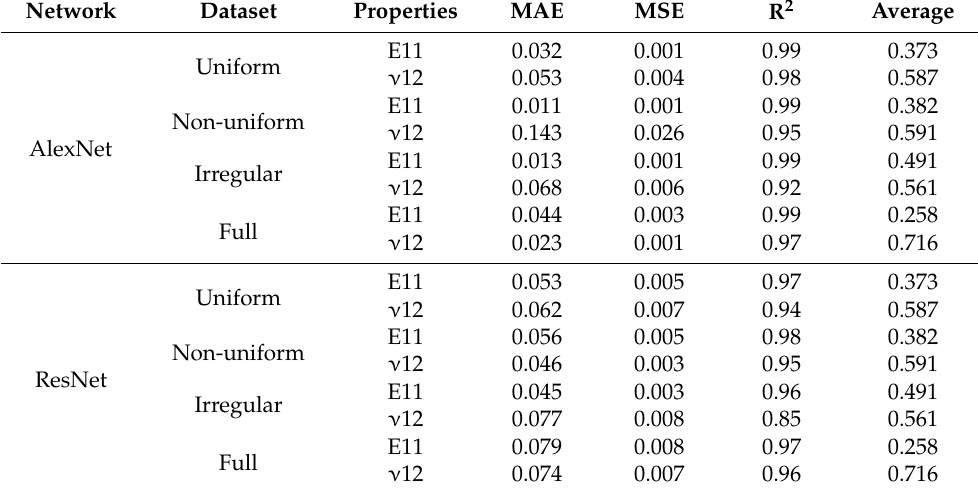
Table 1. Using AlexNet and ResNet, we evaluated the performance of our implemented ResNet and AlexNet networks with an 85:15 train–test split. The performances were measured according to the error between the FEM results and the predicted Young’s modulus and Poisson’s ratio derived from the trained AlexNet and ResNet. Statistical descriptors are provided for context (MAE, MSE, R-value, and average of distributed data using the max–min normalization